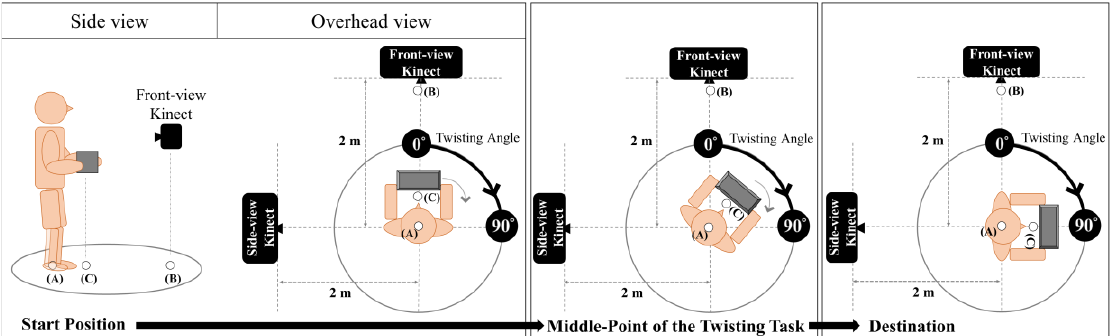
Figure 1. The simulated twisting task in this study. (A) is the point on the ground between the participant’s feet, (B) is the point on the ground underneath the Front-view Kinect, and (C) is the projected point on the ground from the midpoints of the participant’s two wrist locations.